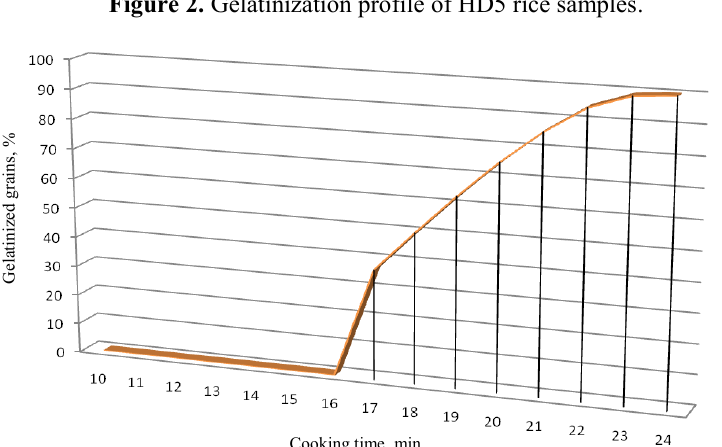
Figure 3. Gelatinization profile of HD6 rice